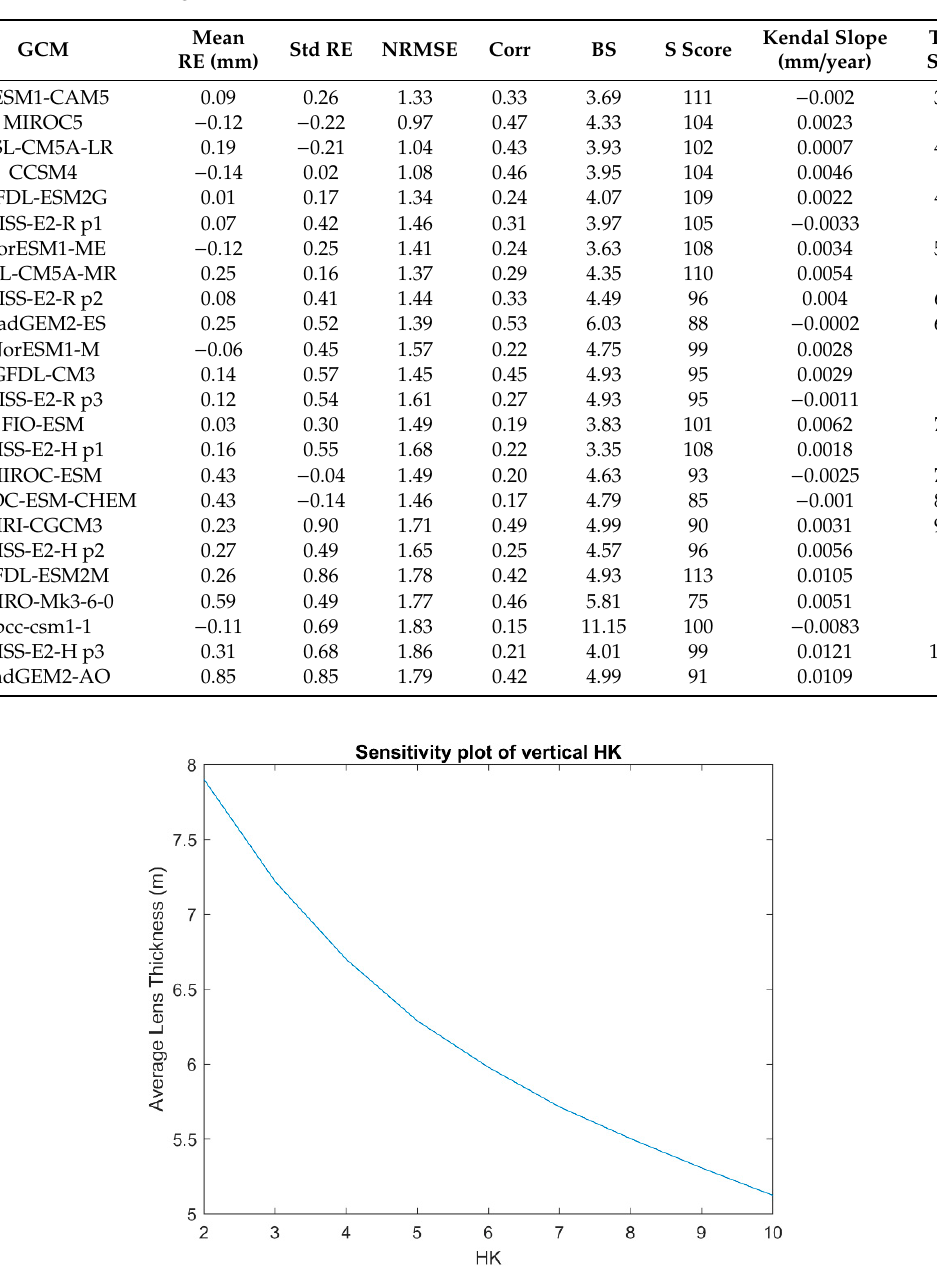
Table A2. GCM performance results for monthly rainfall rates in Gan for RCP Scenario 2.6, ranking best to worst according to the total score.